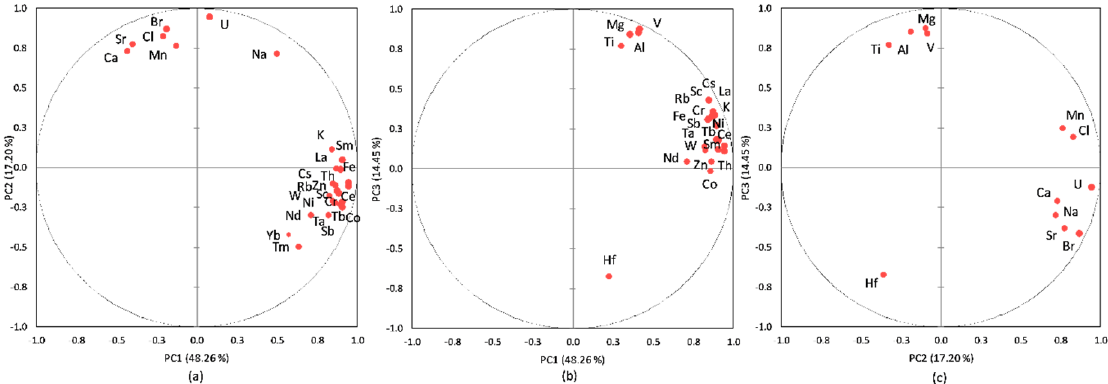
Figure 24. PCA box plots, PC1 versus PC2 ( a ), PC1 versus PC3 ( b ), and PC2 versus PC3 ( c ) obtained for quantified elements in sediment sample of Caineni Lake.